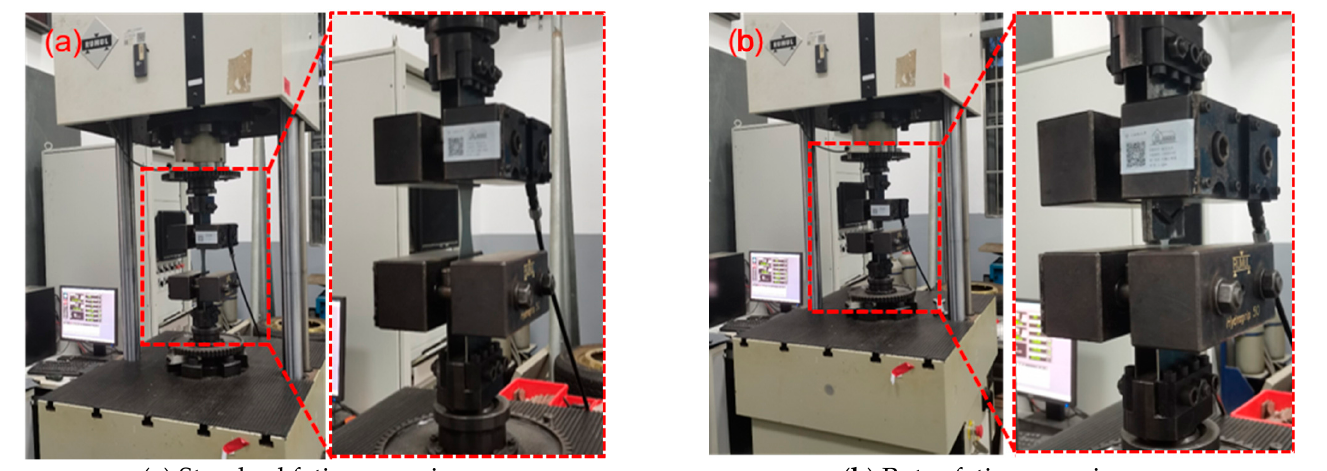
Figure 21. Fatigue specimen test diagram.